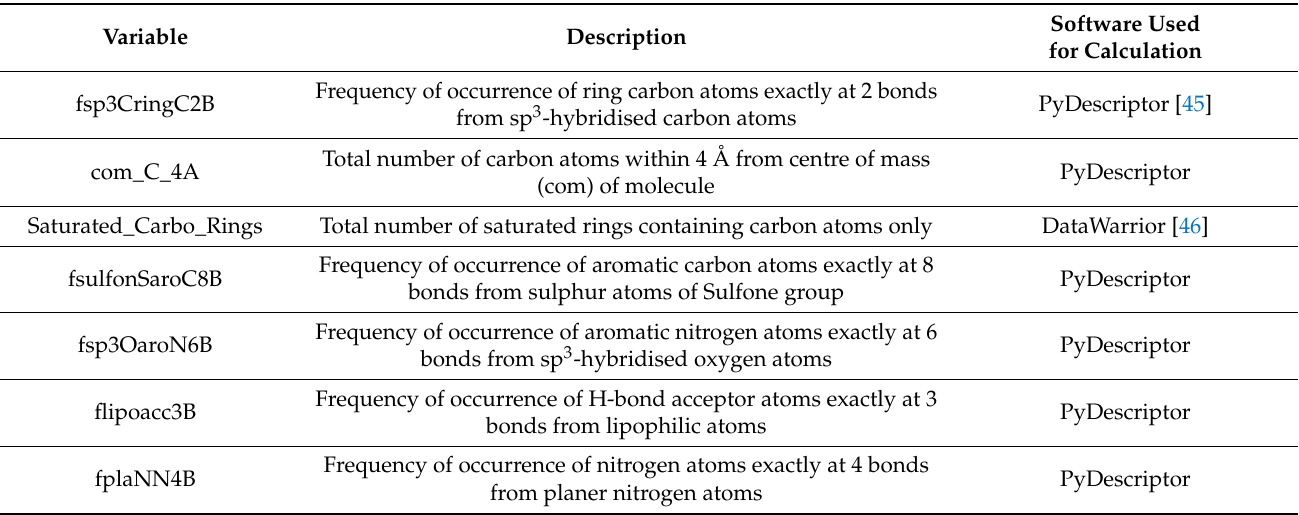
Table 1. Details of molecular descriptors present in